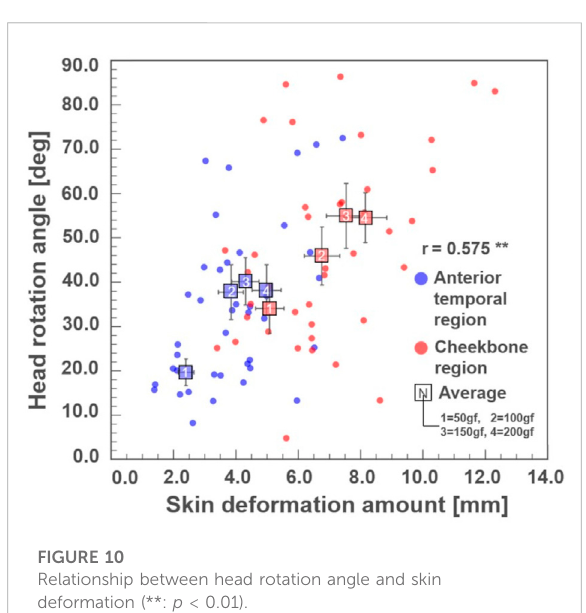
Relationship between head rotation angle and skin deformation (**: p <